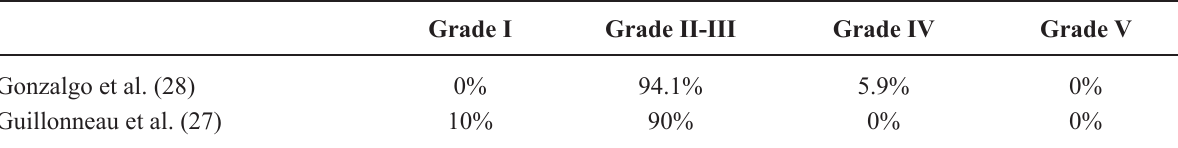
Table 2 – Examples of the application of the update classification with regard to the complications of 2 laparoscopic radi - cal prostatectomy